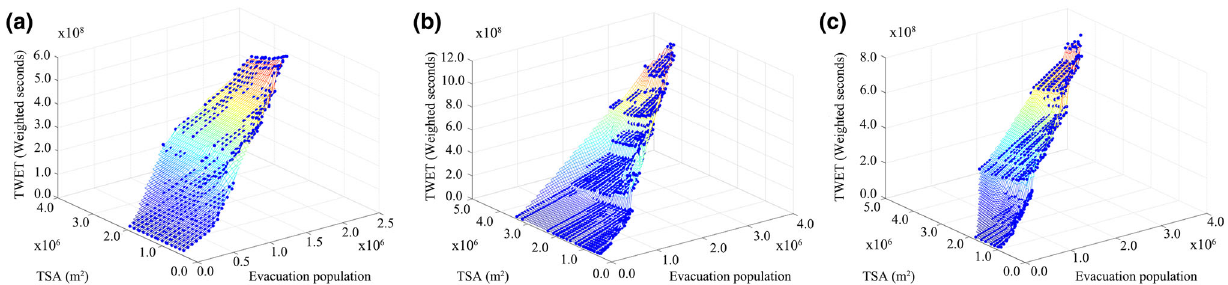
Fig. 11 Distribution and interpolation of the simulation result values of evacuation population, total shelter area (TSA), and total weighted evacuation time (TWET) joint relationship. a – c Location 1, Location 2, and Location